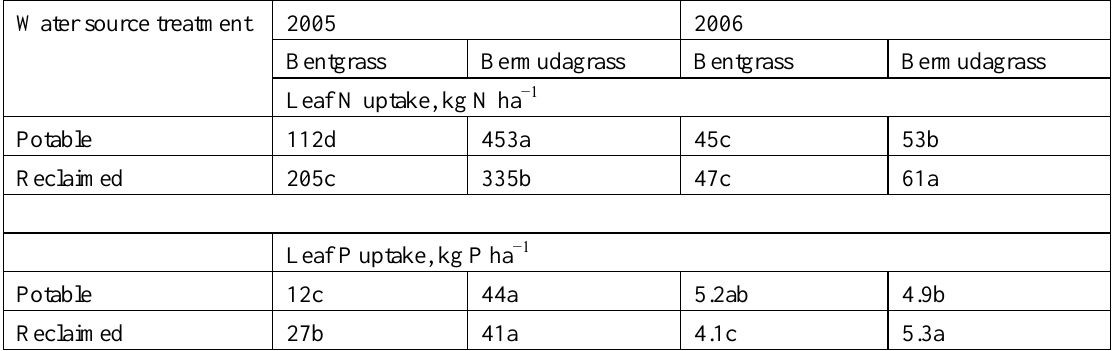
Table 3. Seasonal turfgrass N and P assimilation: May to October, 2005; May and July, 2006. Water source treatment 2005 2006 Bentgrass Bermudagrass Bentgrass Bermudagrass Potable Reclaimed Leaf P uptake, kg P ha −1 Potable 12c 44a 5.2ab 4.9b Reclaimed 27b 41a 4.1c 5.3a Numbers followed by the same letters within a plant tissue variable are not significantly different at the 0.05 level of